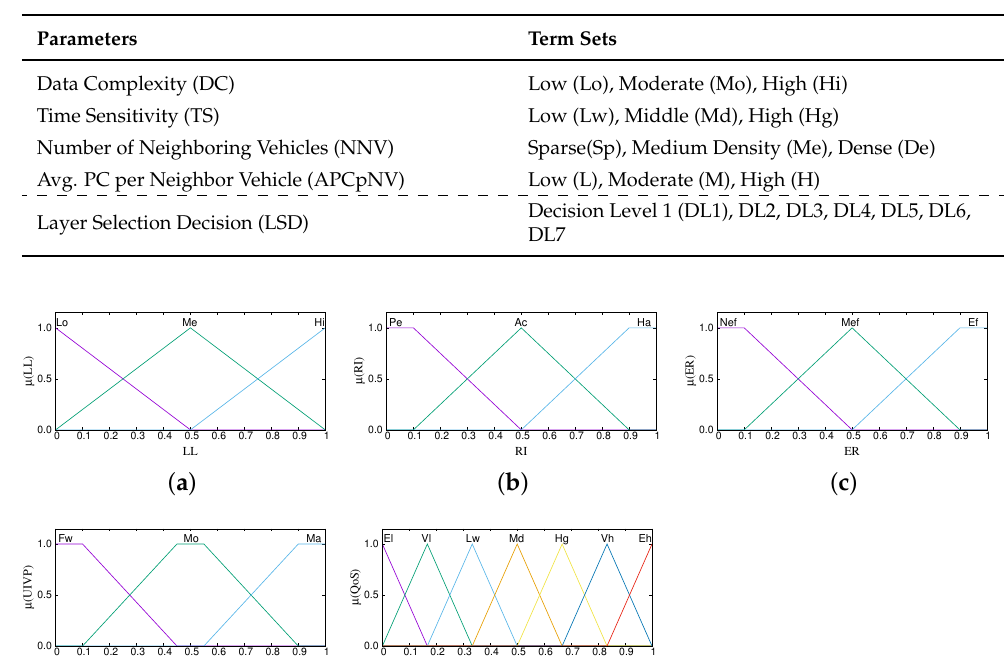
Table 3. Parameters and term sets for FS-CFELS.